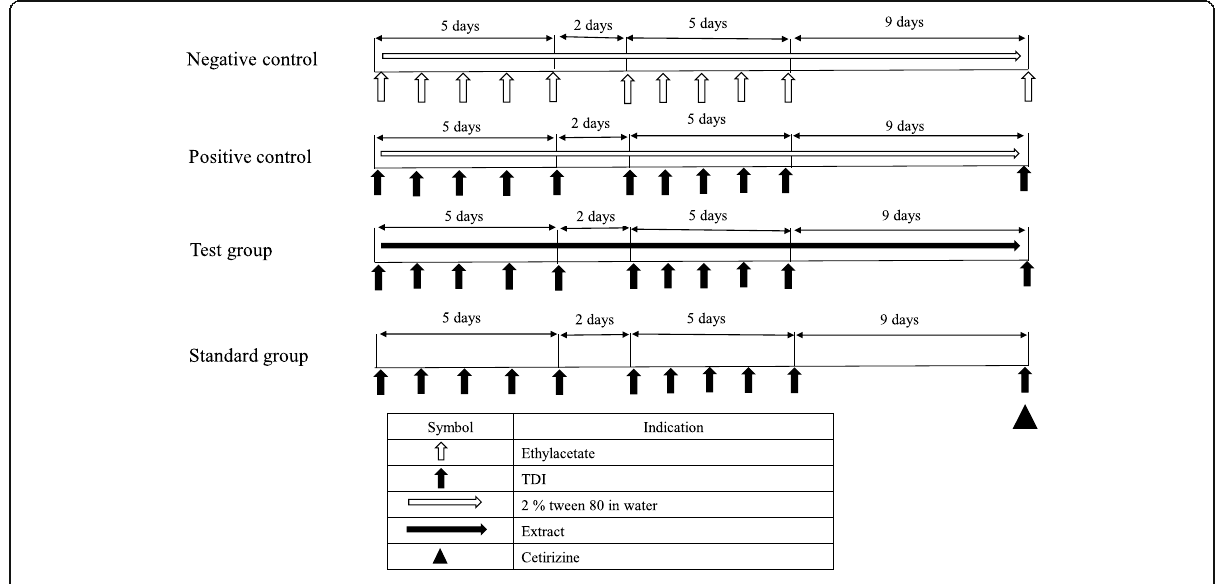
Fig. 1 Experimental protocol for anti-allergic activity evaluation in mice